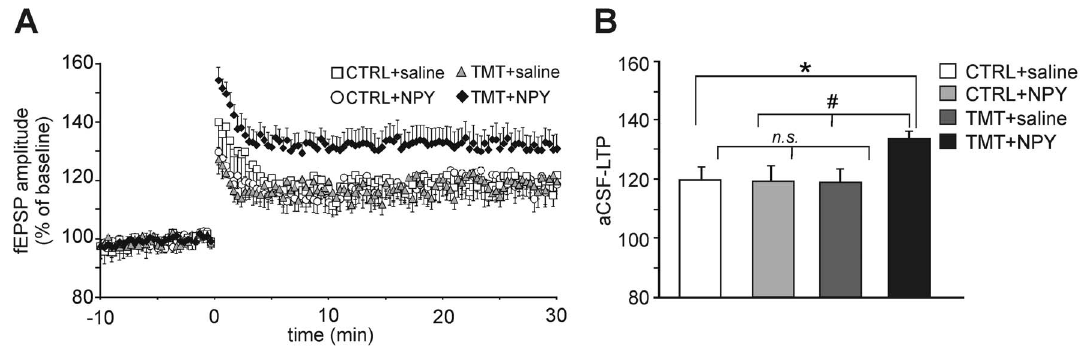
Figure 4. Long-term potentiation (LTP) at medial perforant pathway (MPP)-dentate granule cell (DGC) synapses. A . Time course of MPP-DGC LTP induced by high frequency stimulation (HFS) (delivered at time 0) in hippocampal slices from rats belonging to the four experimental groups (CTRL + saline, CTRL + NPY, TMT + saline, TMT + NPY). Recordings were performed in normal aCSF (i.e, in the absence of GABA A receptor blockade) and show enhanced LTP (aCSF-LTP) in slices from the TMT + NPY group compared to all the other experimental groups. Results are expressed as percentages of baseline fEPSP amplitude (100%). B . Bar graphs comparing LTP magnitudes observed during the last 5 min of recording in the different experimental groups. Error bars indicate S.E.M. values. *p , 0.05 vs CTRL + saline-treated rats; # p , 0.05 vs TMT + NPY group, (Student’s t test);